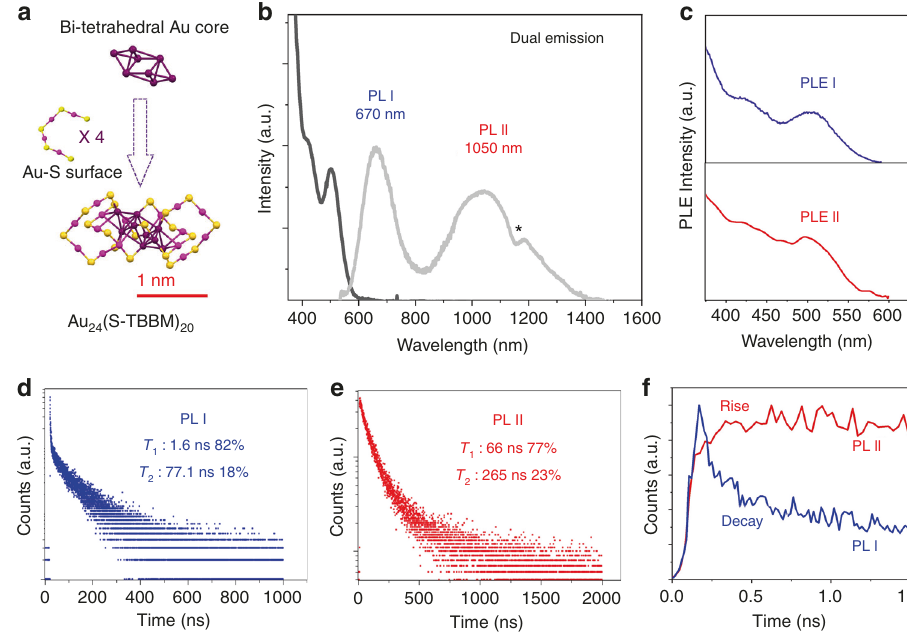
Fig. 1 Optical properties and PL dynamics of Au 24 . a Anatomy of the atomic structure of Au 24 determined by single-crystal X-ray diffraction 30 . Purple = core Au; magenta = surface Au; yellow = S; Carbon tails are omitted for clarity. b UV-Vis absorption (black) and PL (gray) spectra (the asterisk denotes the spectrum “ structuration ” , which is induced by the solvent). c PL excitation spectra for the two emissions, measured at 650 nm (blue) and 1050 nm (red), respectively. d , e Time-correlated single-photon counting (TCSPC) trajectories of the PL I (detected from 550 to 750 nm) and PL II (detected from 900 to 1000 nm). f Comparison of the TCSPC trajectories of PL I (blue) and PL II (red) in the early 1.5 ns. PL photoluminescence, τ PL lifetime component.